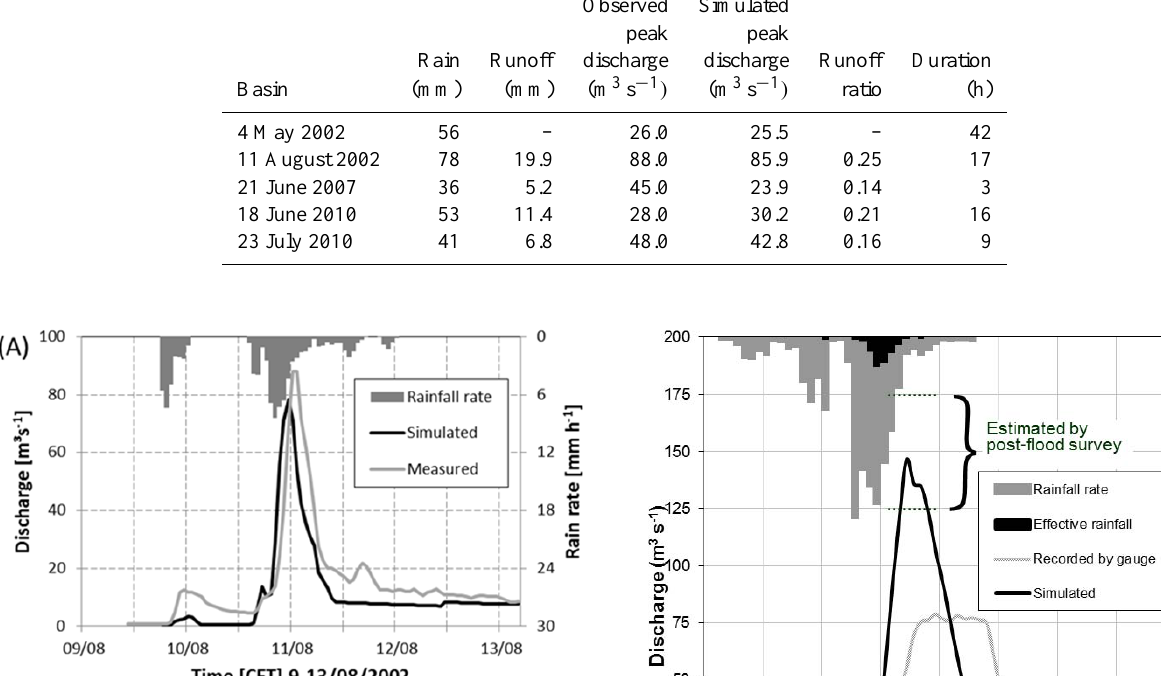
Table 2. Rainfall and runoff properties for the five flood events observed at Rangendingen between 2002 and 2010. Observed Simulated